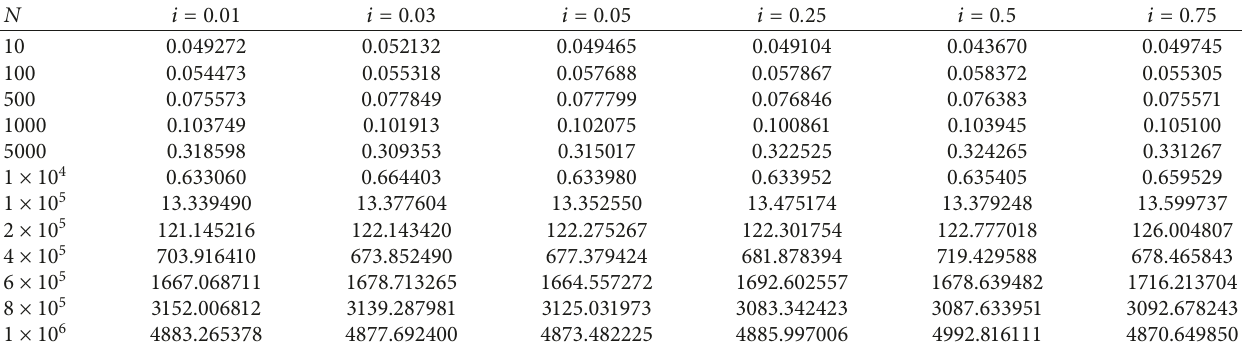
10 6 with interest rate i 0 . 05. × (cid:31) 10 6 with c 0 . 3. × (cid:31)